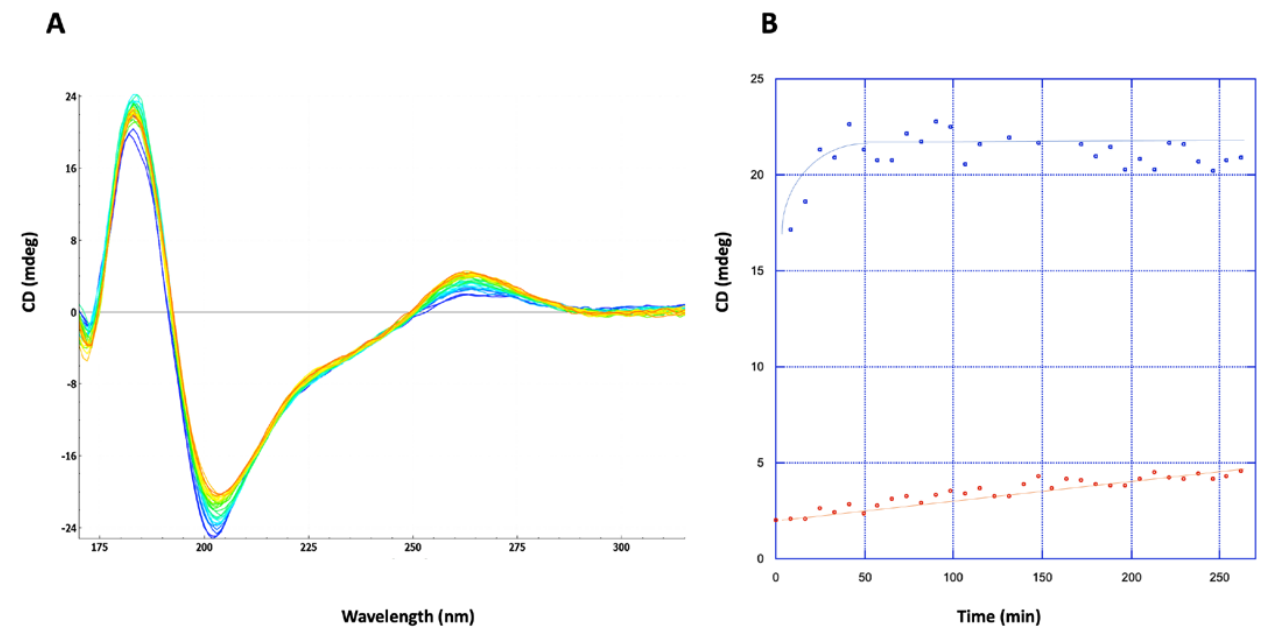
Figure 6. ( A ) Observation of RNA I and RNA II annealing by Hfq-CTR using SRCD (from blue t = 0 min to red t = 260 min). ( B ) Kinetics of annealing at 183 (blue) and 262 nm (red). Here an initial increase in A-form helix formation (183 nm) is followed by a slower gradual formation of base pairing (262 nm). Kinetic constants k catapp were determined during initial rate conditions. Note that spontaneous RNA annealing also occurs without the protein but to a lesser extent, and it was subtracted.